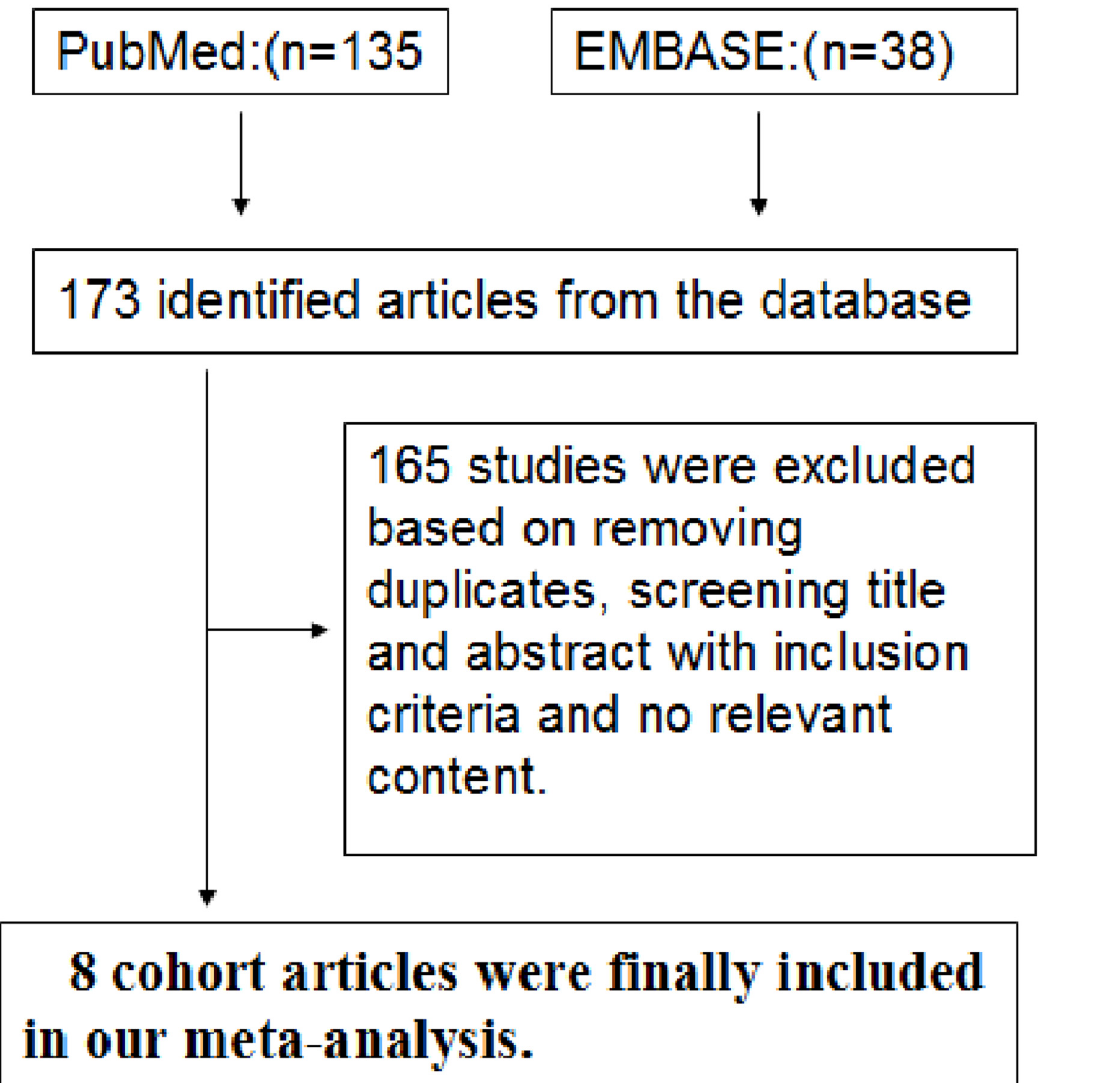
Fig 1. Flow Chart Illustrating the Literature Search for Cohort Studies on Opioids in Relation to